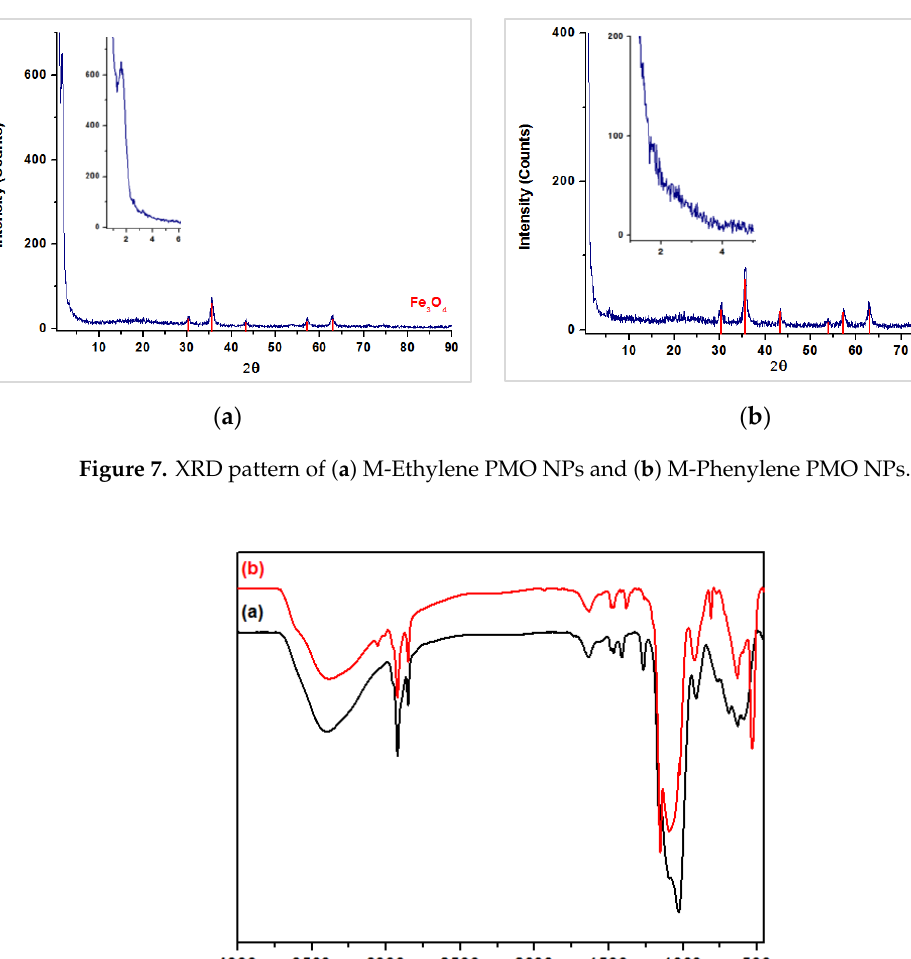
Figure 7. XRD pattern of ( a ) M-Ethylene PMO NPs and ( b ) M-Phenylene PMO NPs.